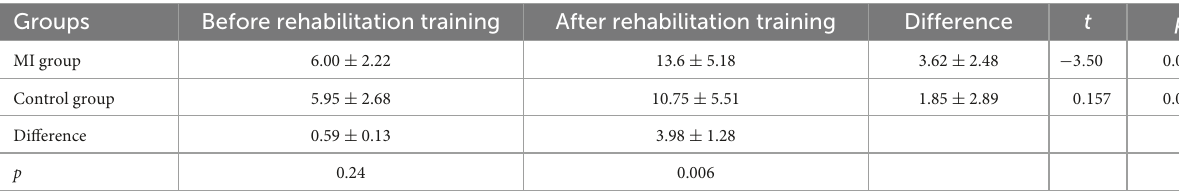
TABLE 3 Comparison of MAS scores on the affected side between the MI and control group. Groups Before rehabilitation training